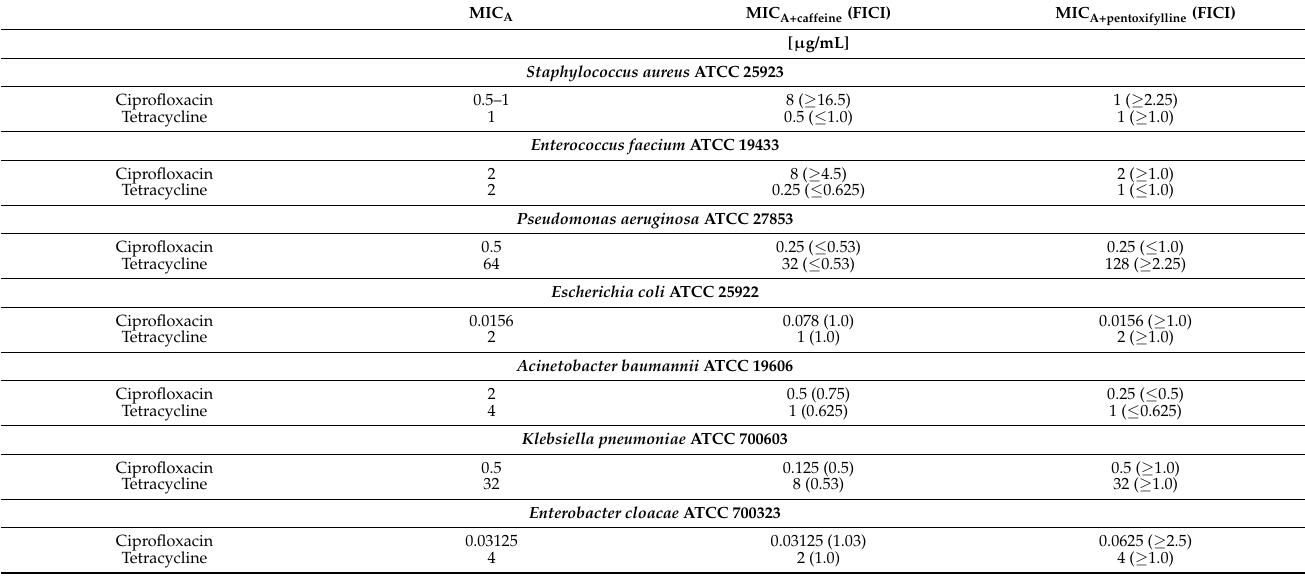
Table 4. The influence of xanthines on antimicrobial activity of selected antibiotics. MIC